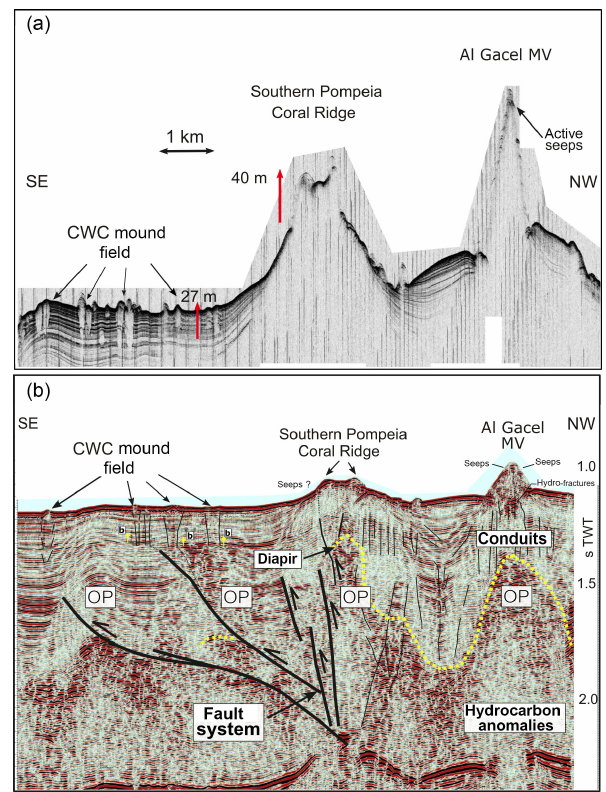
Figure 3. Ultra-high-resolution (a) and multichannel (b) seismic profiles showing geological features in southern Pompeia Province. Note mud diapirism has been described in this area (Vandorpe et al., 2017). OP represents the overpressure